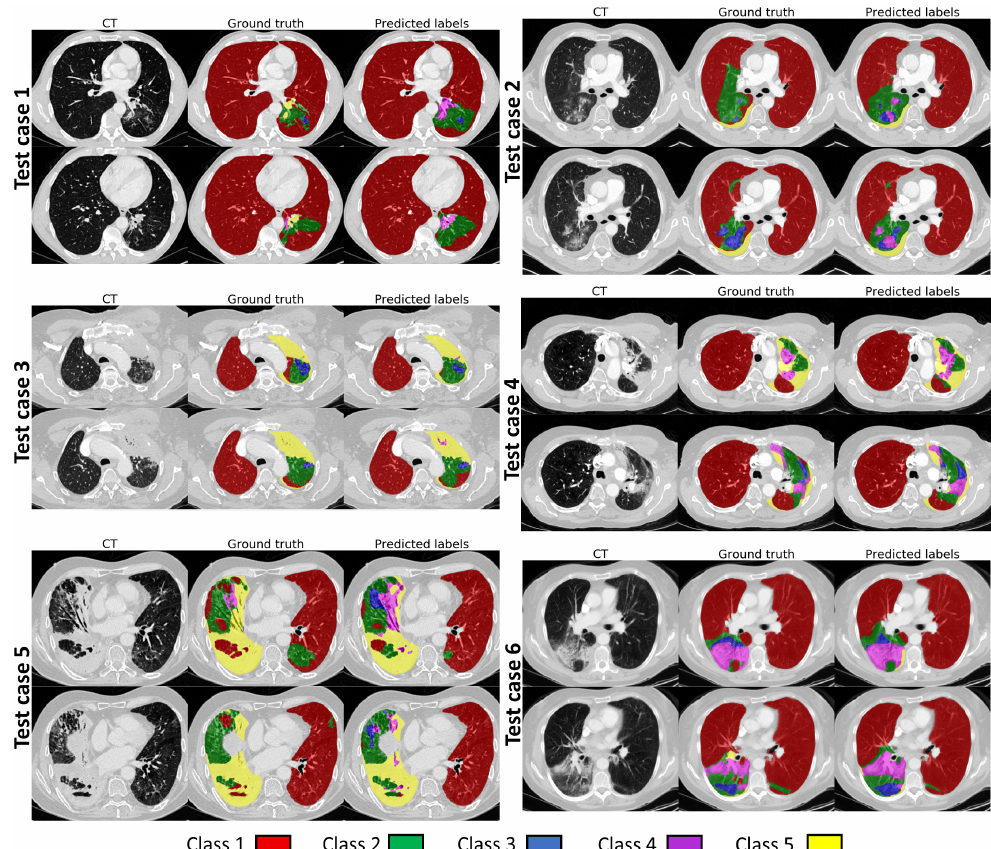
Figure 5. Visual comparison of the segmentation results on the testing set. For each of the cases the time point where the most of the lung parenchymal abnormality was present was